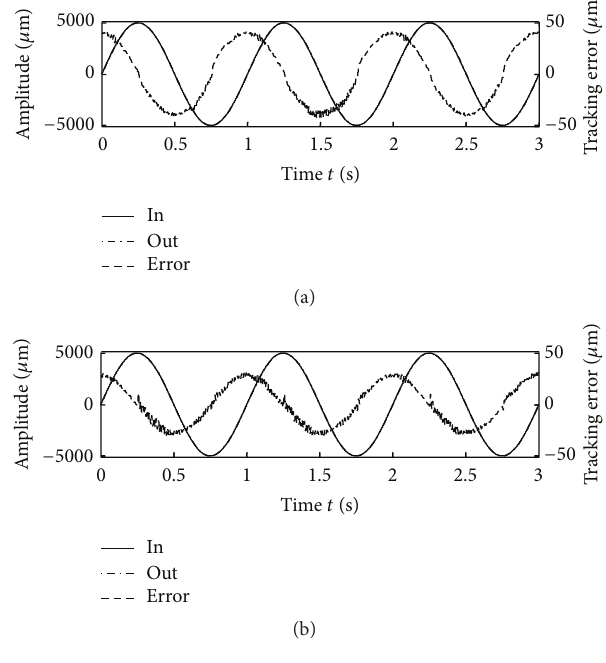
Figure 4: (a) PID. (b) PID +